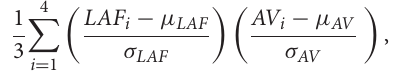
population was relatively constant on day 3 in week 2. On the contrary, the population was 44.8% lower on day 3 in week